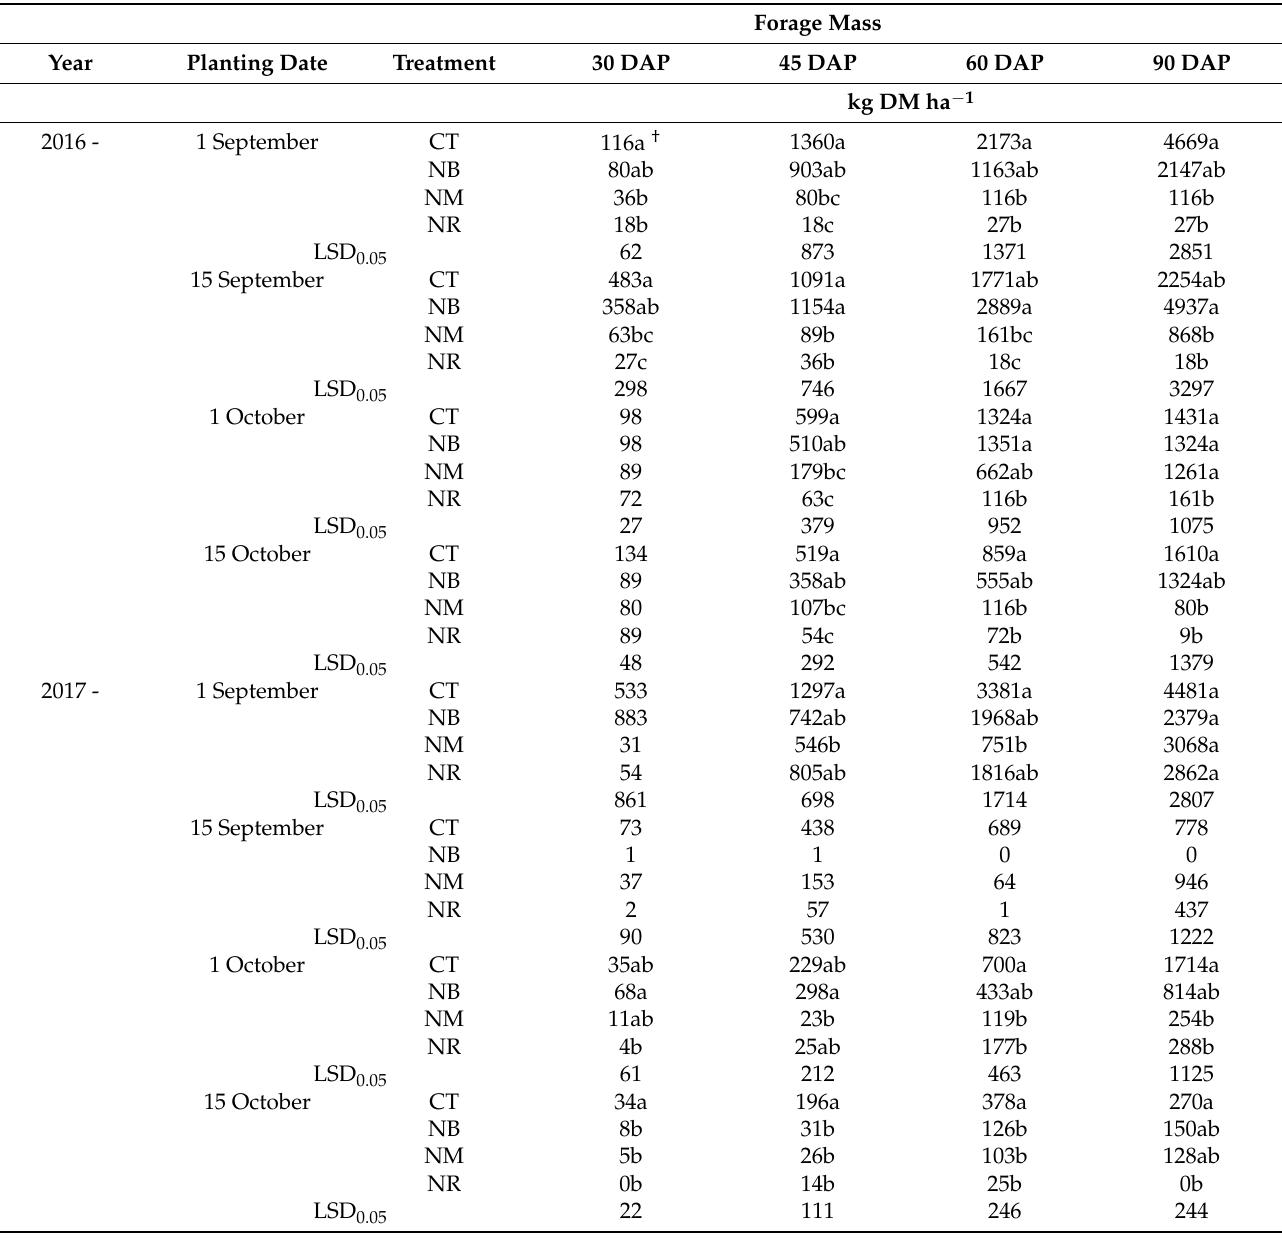
Table 2. Forage mass of hybrid turnip at each land preparation method: conventional till (CT), no-till burn (NB), no-till mow (NM), and no till with residue (NR) land preparation methods on four planting dates: 1 September, 15 September,